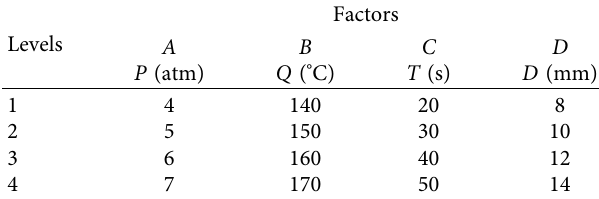
Figure 3: Marked positions.